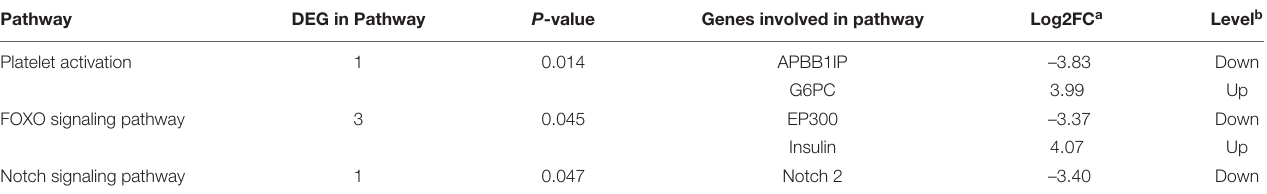
TABLE 5 | Different expression unigene KEGG significant enrichment analysis in spleen of hybrid grouper fed fresh fish oil (R group) and highly oxidized fish oil (H group). Pathway DEG in Pathway P